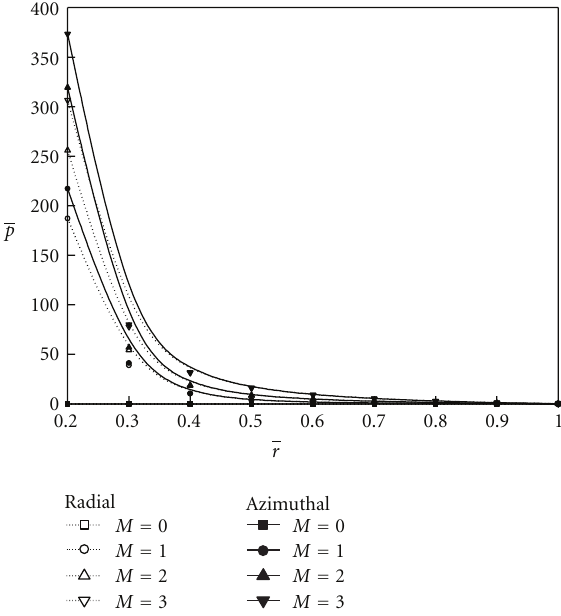
Figure 2: Variation of nondimensional mean film pressure p with r for di ff erent values of M with β = 0 . 05, l = 0 . 3, c = 0 . 3, and ψ = 0 .